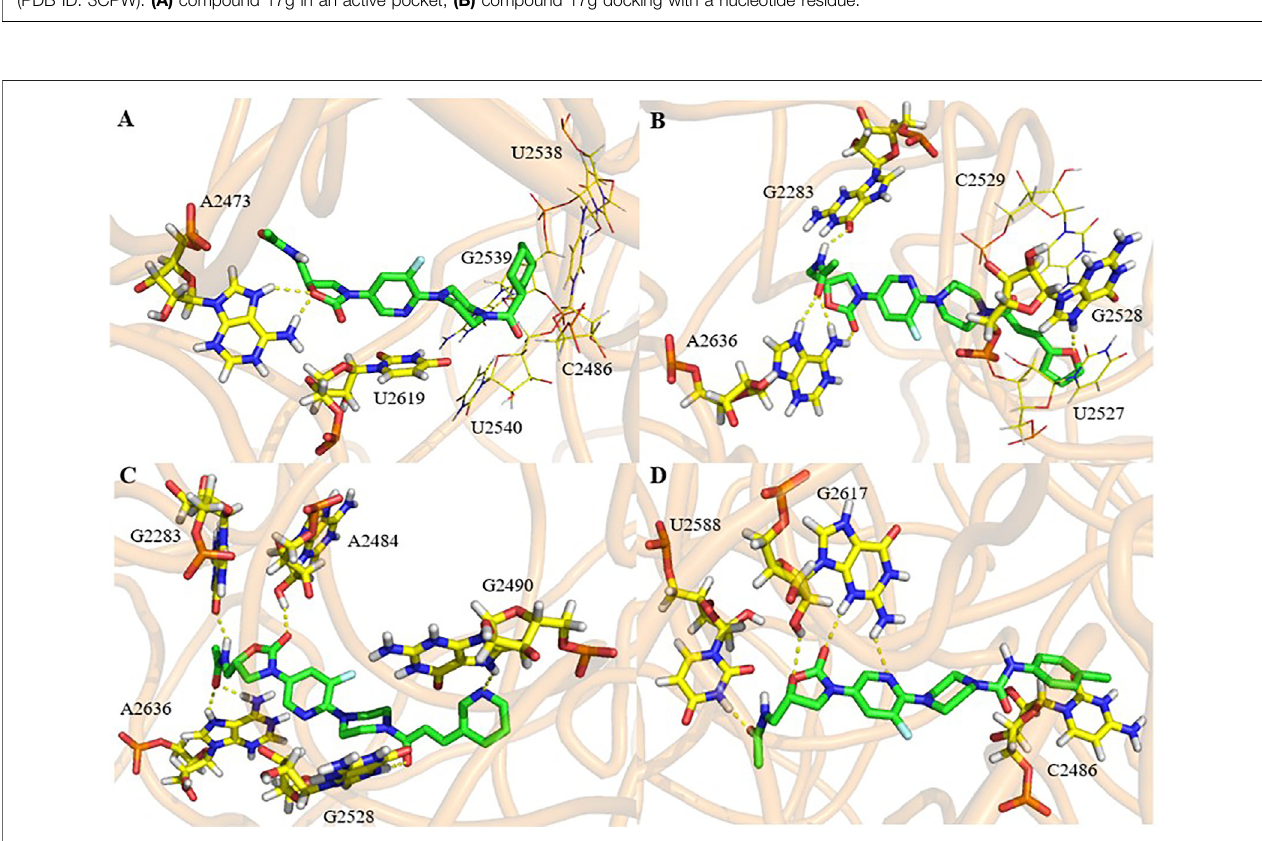
FIGURE 6 | Docking study of compounds 21b (A) , 21d (B) , 21e (C) and 21f (D) with ribosomal peptidyl transferase center (PTC) of 50S ribosomal subunit from Haloarcula marismortui (PDB ID: 3CPW).